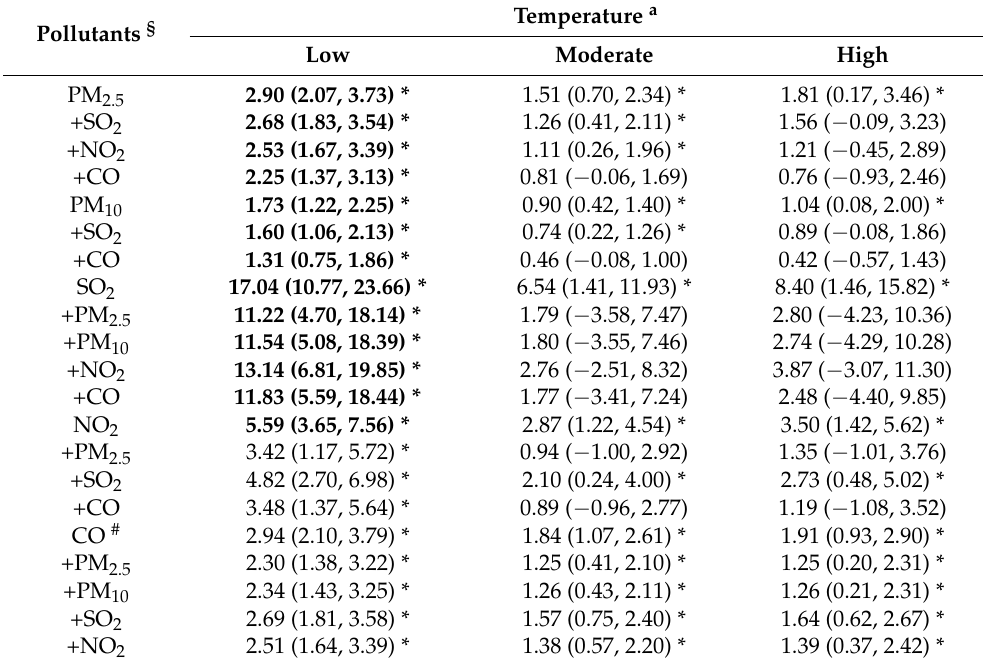
Table 2. Percentage change in COPD hospital admissions per 10 µ g/m 3 increase in air pollutants (CO per 0.1 mg/m 3 ) by temperature levels in urban areas of Chengdu, China, 2015–2016. Temperature a Pollutants § Low